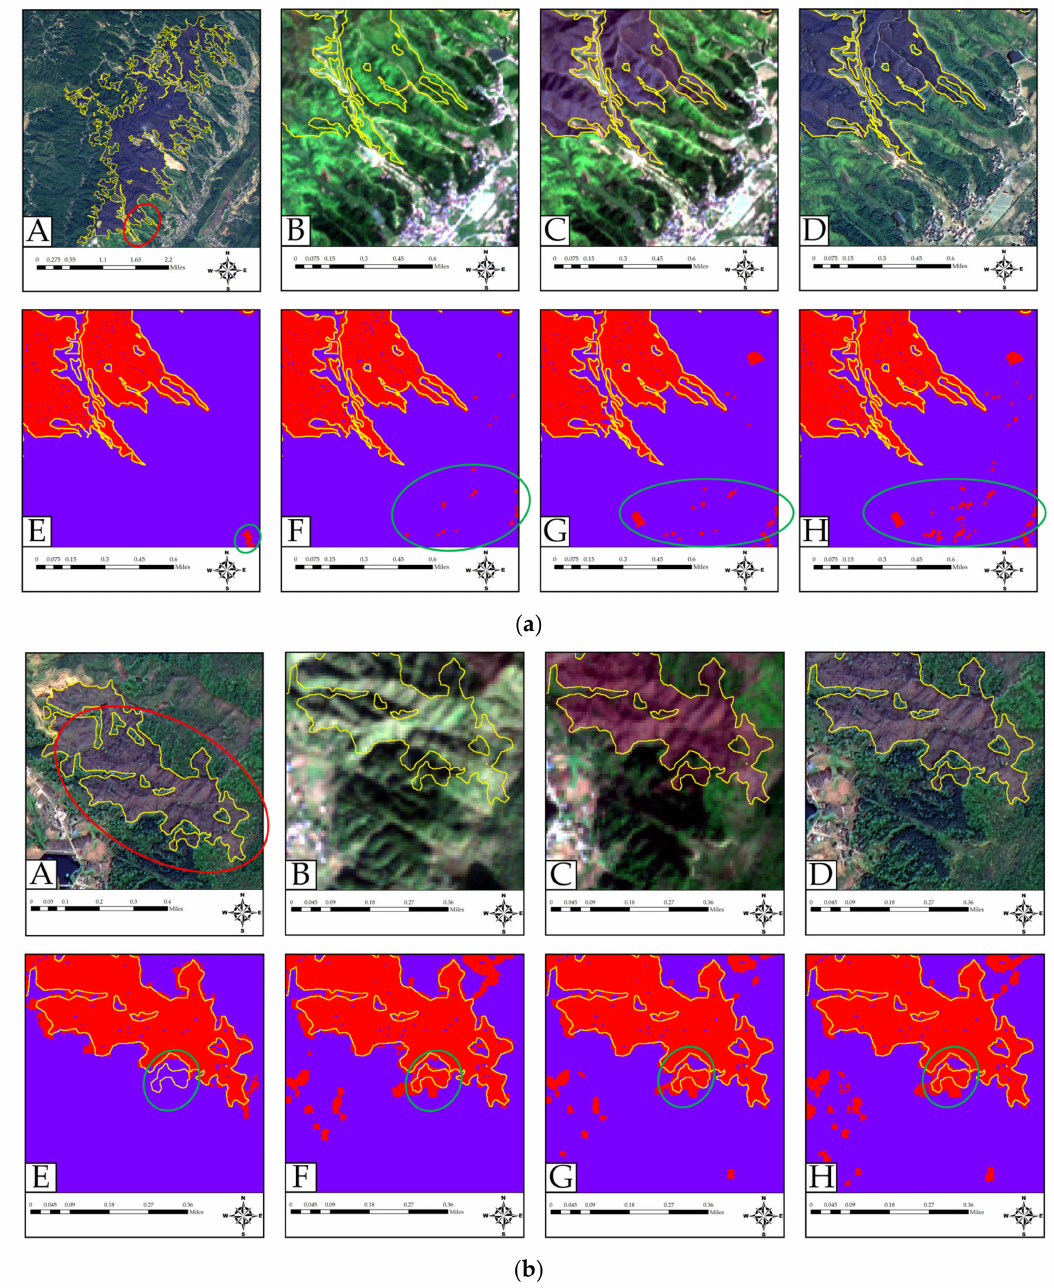
Figure 6. The burned area mapped at subpixel level using different algorithms in the Sentinel-2 image over fire-scar site in 1HYHD ( a ), 11ZJJSZ ( b ). The yellow polygon in panels ( A – H ) is the vector data of fire-scar sites. Panels ( B – H ) are zoomed view of the red circle in Panel ( A ). Panels ( E – H ) are burned area mapped at subpixel level, in which the red area represents burned area and purple color represents background. Panel ( A ) shows the fire-scar site derived from the GF series data sets. Panel ( B ) shows the pre-fire site based on the Sentinel-2 images. Panel ( C ) shows the post-fire site. Panel ( D ) is the post-fire site based on the GF series data sets. Panel ( E ) is the burned area mapped at subpixel using BASM-FERB. Panel ( F ) shows the burned area mapped at subpixel level using BASM-RF. Panel ( G ) is the burned area mapped at subpixel level using BASM-BPNN. Panel ( H ) is the burned area mapped at subpixel used